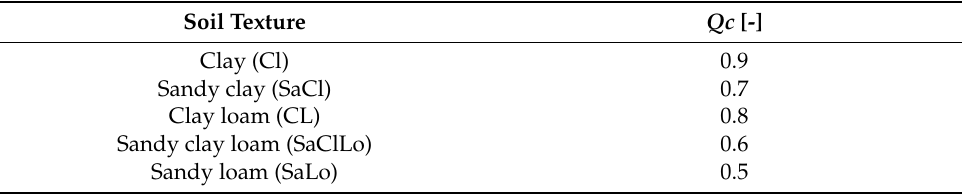
Table 3. Quickflow separation coefficient, based on soil